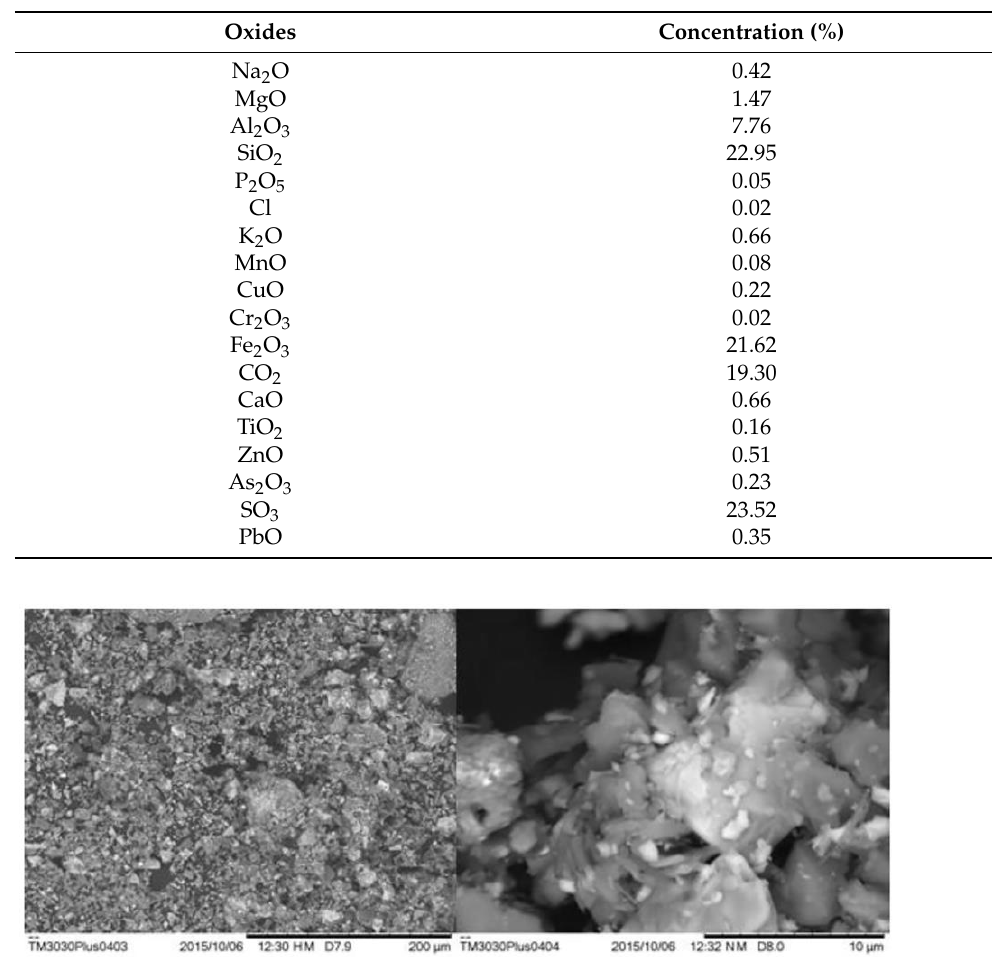
Table 1. Chemical composition of the mine tailing obtained by XRF.